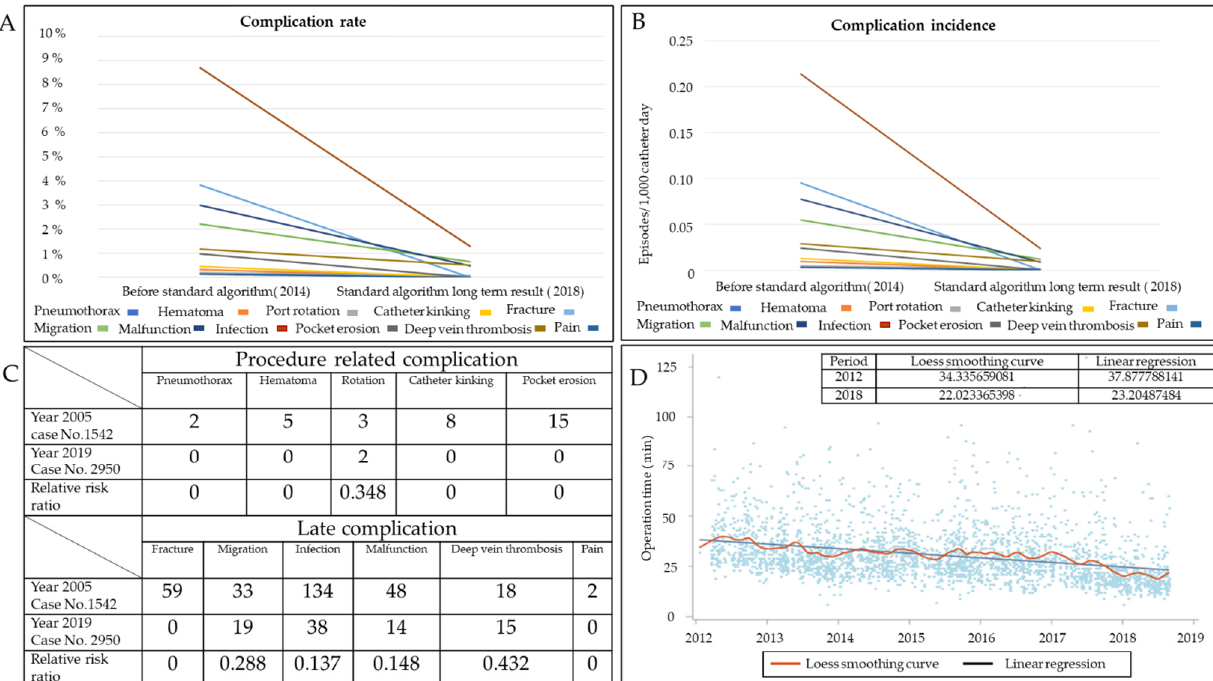
Figure 2. Variation trends of complication rate, incidence, and operation. ( A ) Variation trends of procedure- and catheter- related complication rates. ( B ) Variation trend of procedure- and catheter-related complication incidences. ( C ) Relative risk ratio between Year 2005 and Year 2018 cohorts. ( D ) Variation trend of operation time. Table 2. Complication rate, incidence, and reason for re-intervention.